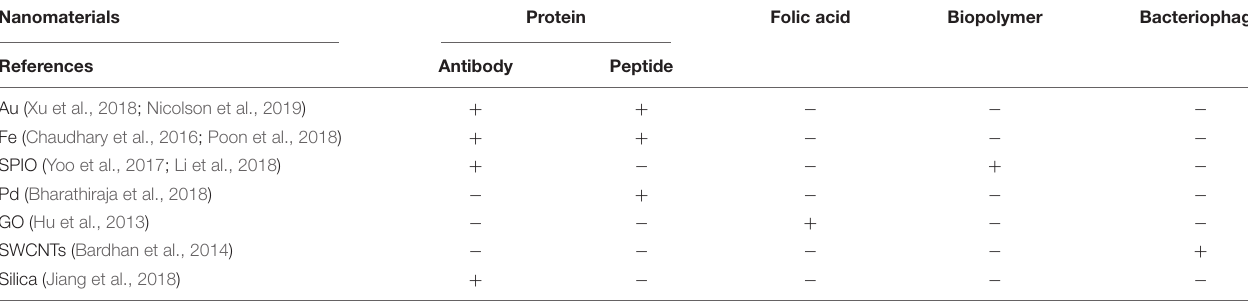
TABLE 2 | Application of different biomimetic functionalized nanomaterials in bioimaging.